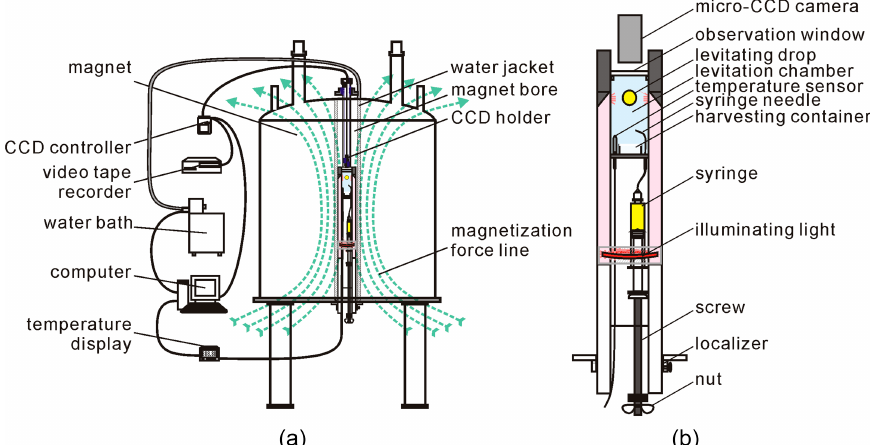
Figure 8. Schematic illustration of a container-less levitation device assembled in a superconducting magnet [44]. ( a ) The containerless levitation setup; ( b ) the levitation unit. Reproduced from reference [44] with permission from AIP Publishing LLC and Copyright Clearance Center.